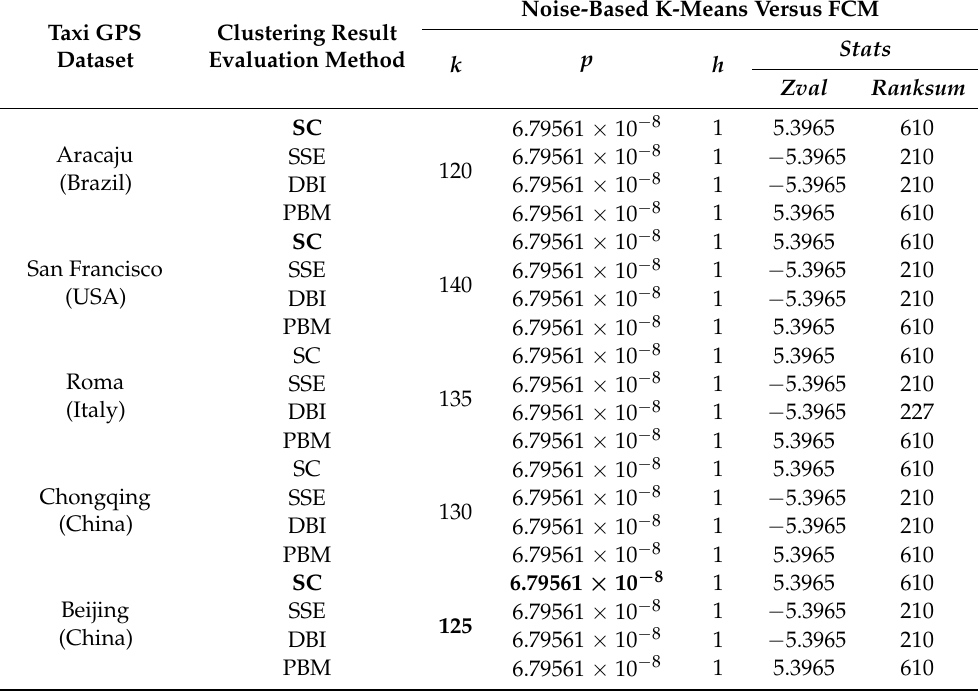
Table 8. Statistical analysis results of Wilcoxon testing for noise-based K-means vs. FCM.